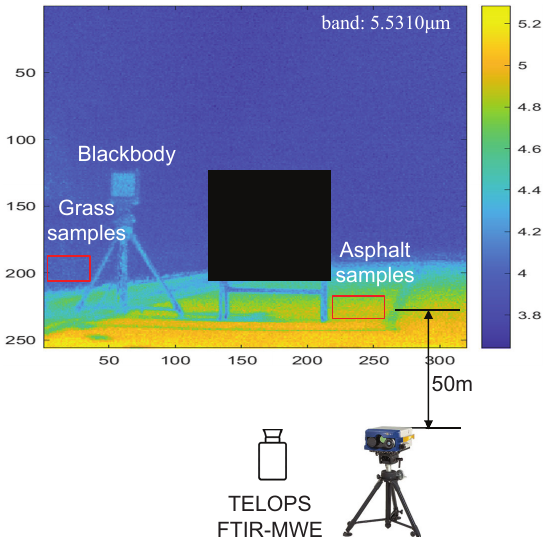
Figure 23. Outdoor field test environment and hyperspectral data acquisition